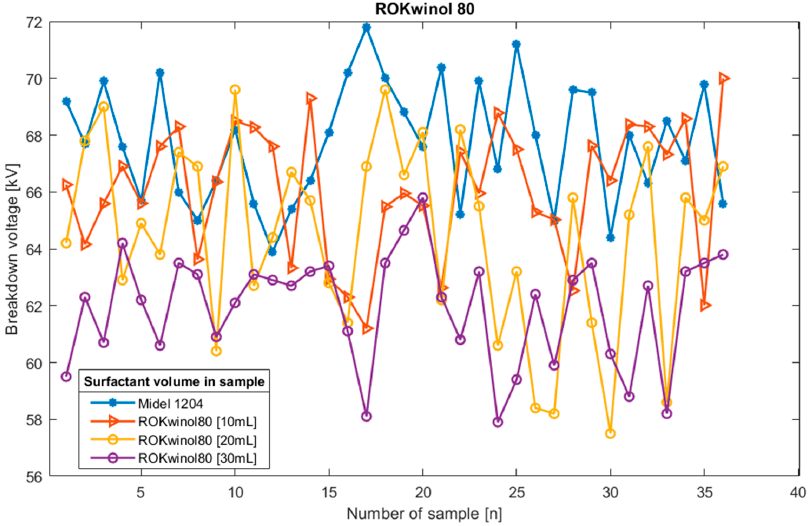
Figure 7. Breakdown voltage plot for oil sample Midel 1204 with different concentrations of surfactant ROKwinol80.